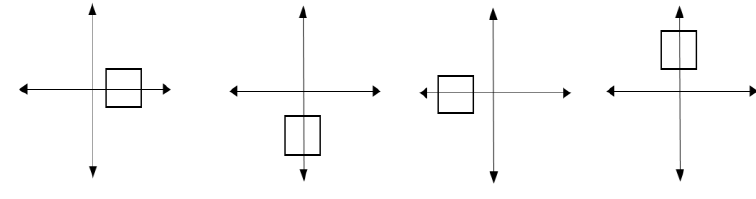
Figure 8. Two quadrant fuzzy area.